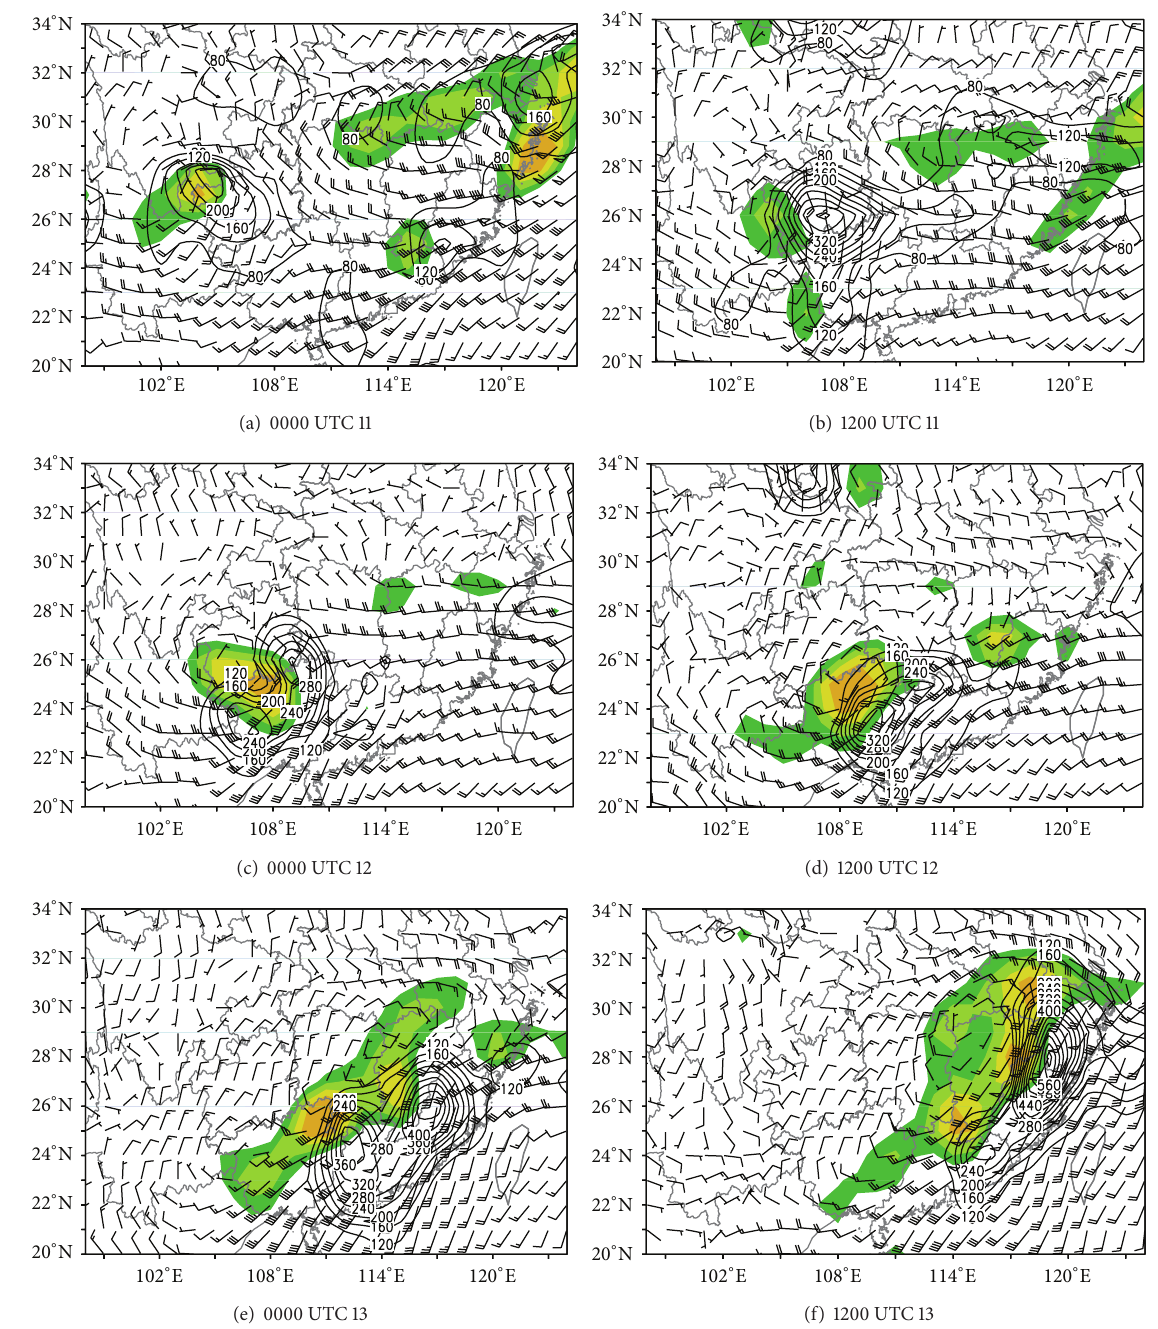
Figure 6: The distribution of storm relative helicity (solid lines in m 2 /s 2 ) and 700 hPa horizontal wind vector (m/s) and vorticity (shaded in 10 −5 s −1 ) over June 11–13,